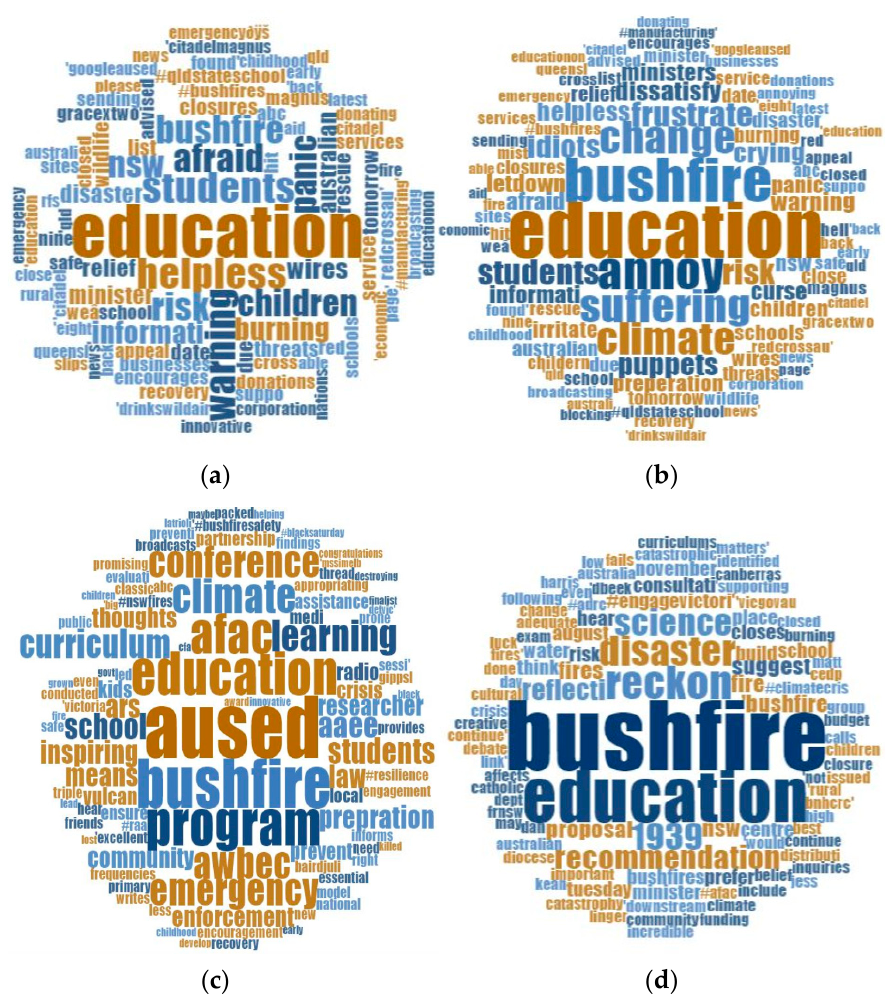
Figure 6. ( a ) Negative sentiments; ( b ) Strongly negative sentiments; ( c ) Strongly positive sentiments; ( d ) Positive sentiments. ( d ) Positive